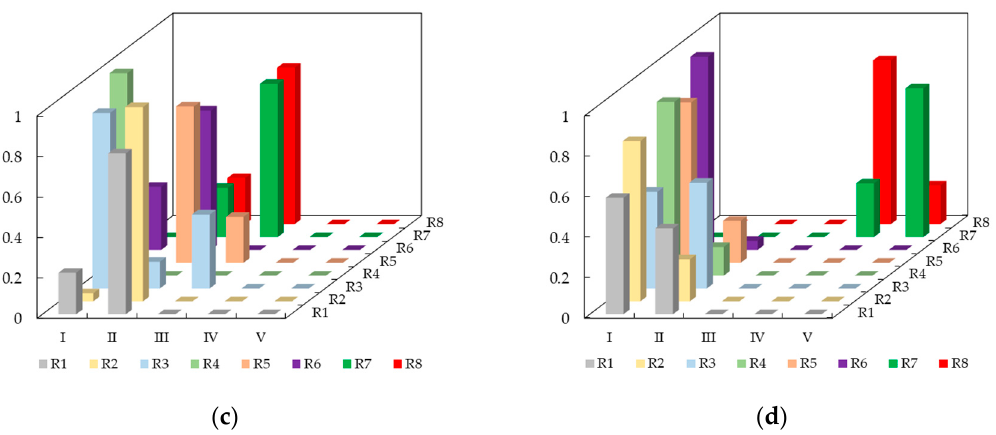
Figure 4. Fuzzy membership values of four administrative regions: ( a ) Hami; ( b ) Changji; ( c ) Kashgar; ( d ) Hotan.